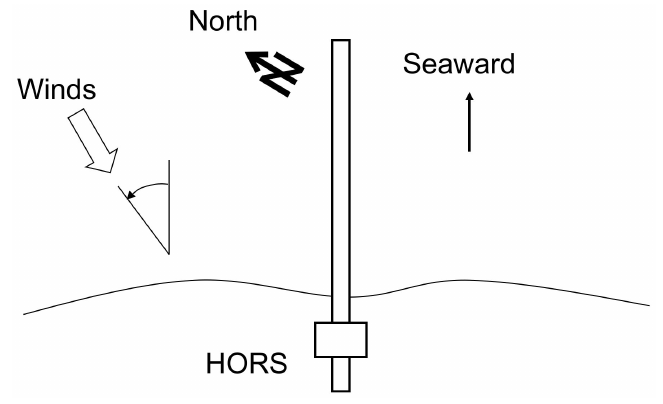
Figure 5. Coordinate system.